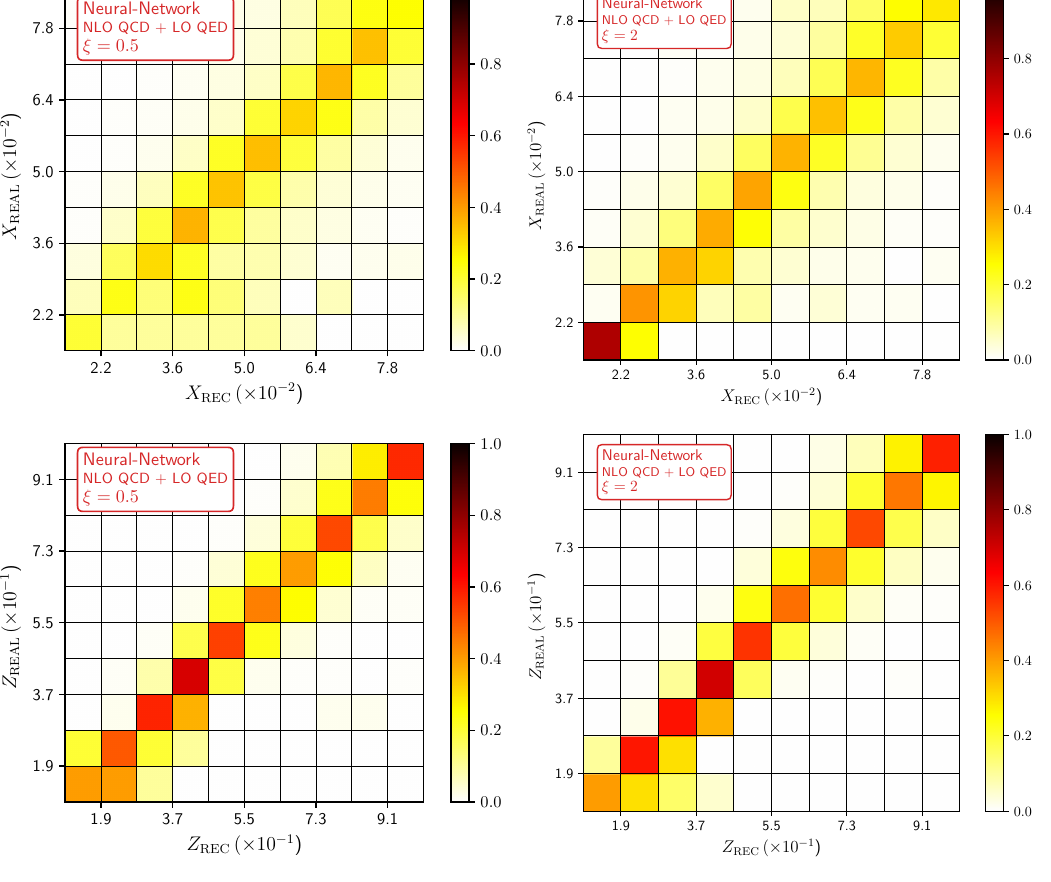
vs. X ob- REAL REC = µ ≡ ξµ . We set ξ = 1 / 2 ( ξ = 2) in R F vs. Z REAL REC